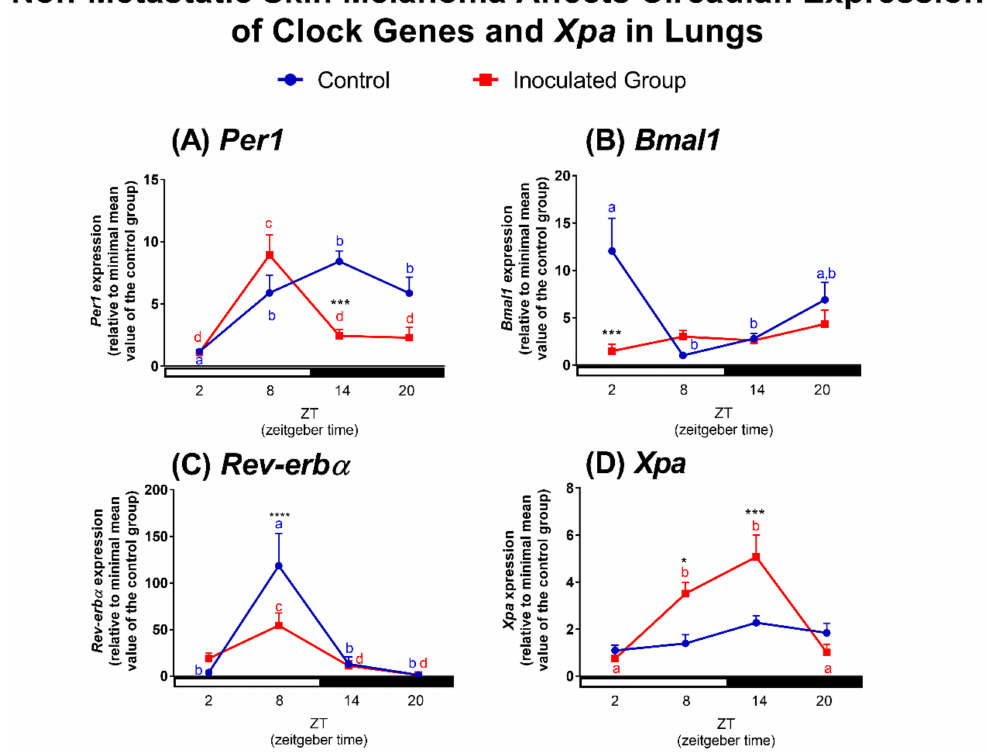
Figure 4. Non-metastatic skin melanoma affects circadian expression of clock genes and Xpa in lungs. Expression of ( A ) Per1 , ( B ) Bmal1 , ( C ) Reverb- α and ( D ) Xpa in lungs of control and tumor-bearing mice. Letters represent significant differences in gene expression within the same group, Two-Way ANOVA followed by Bonferroni post-test. In ( A ) a (cid:54) = b , p < 0.05 and c (cid:54) = d , p < 0.001. In ( B ) a (cid:54) = b , p < 0.01. In ( C ) a (cid:54) = b , p < 0.0001 and c (cid:54) = d , p < 0.05. In ( D ) a (cid:54) = b , p < 0.01. Significant differences between control and tumor-bearing mice were demonstrated by Two-Way ANOVA followed by Bonferroni post-test, and are represented by asterisks having the control lung as reference. * p <0.05, *** p <0.001, **** p <0.0001. Values are presented as the mean expression ( n = 4–6) ± SEM of the gene of interest normalized by 18S RNA, relative to the minimal value found in the control